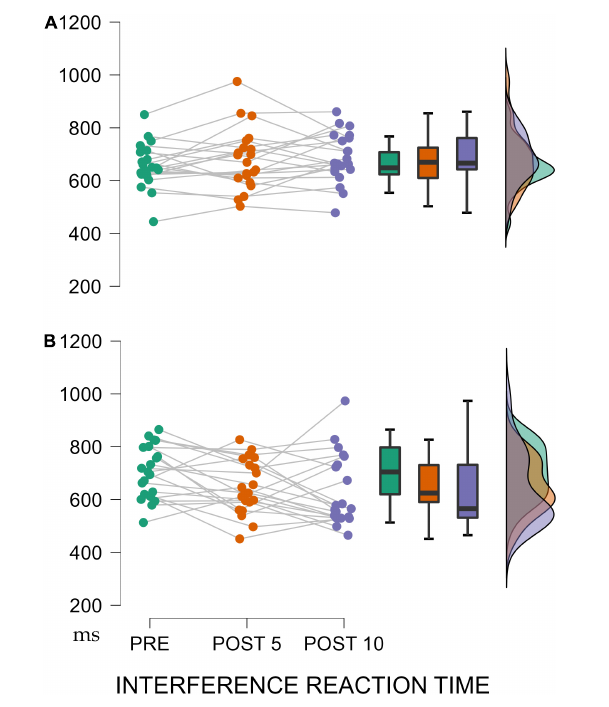
FIGURE 3 | (A) Control Group. (B) Experimental Group. Evolution of CRT during the training process. At the beginning of the study (PRE), after 5 weeks of supervised training (POST 5) and after another 5 weeks of online training during quarantine (POST 10). Significant results shown with p -values are for the experimental group. Data are shown as mean ± standard error.